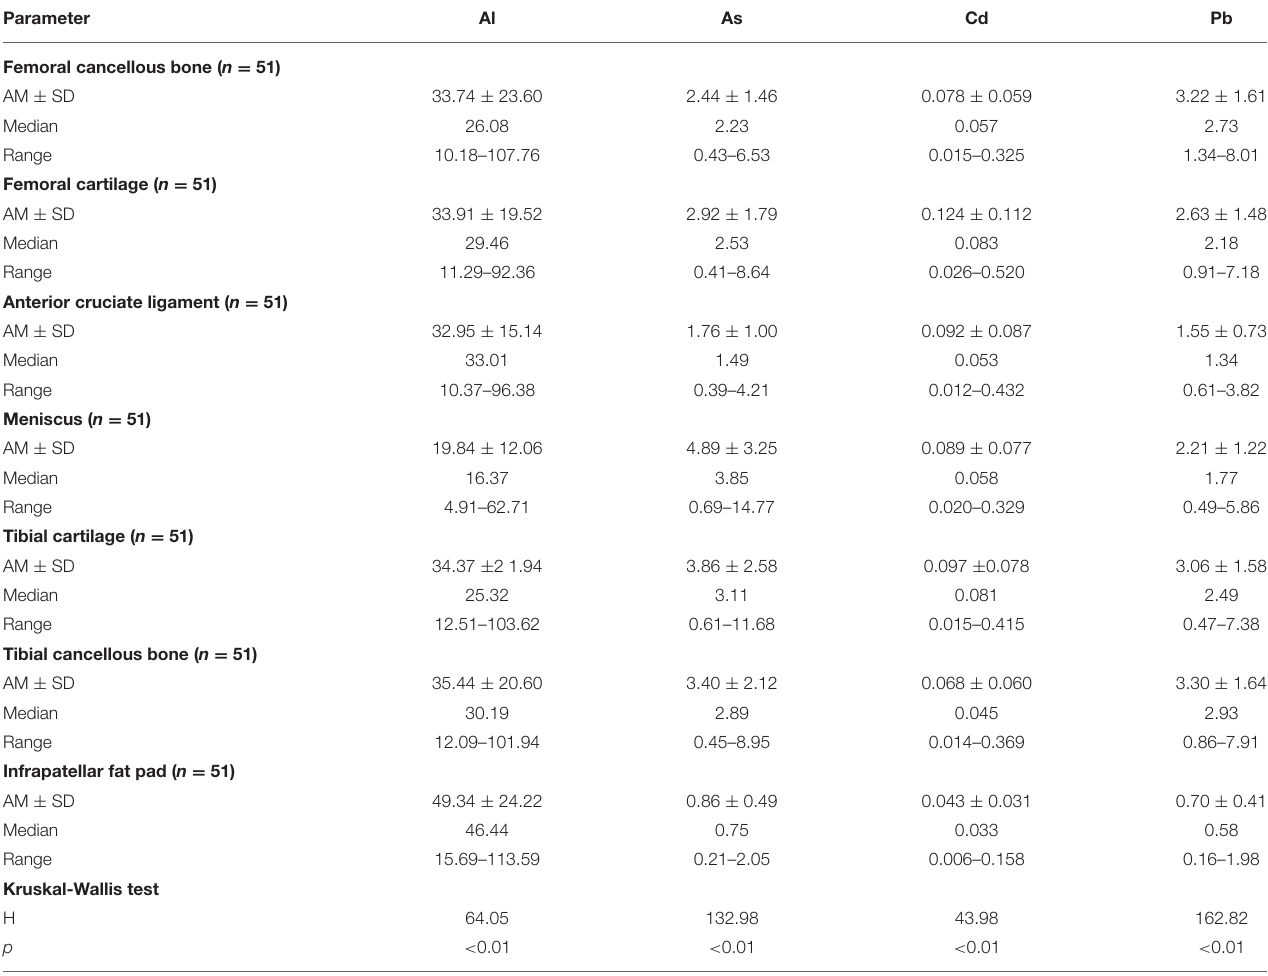
TABLE 3 | Analysis of the Al, As, Cd, and Pb concentrations among the femoral cancellous bone, femoral cartilage, anterior cruciate ligament, meniscus, tibial cartilage, tibial cancellous bone and infrapatellar fat pad. Parameter Al